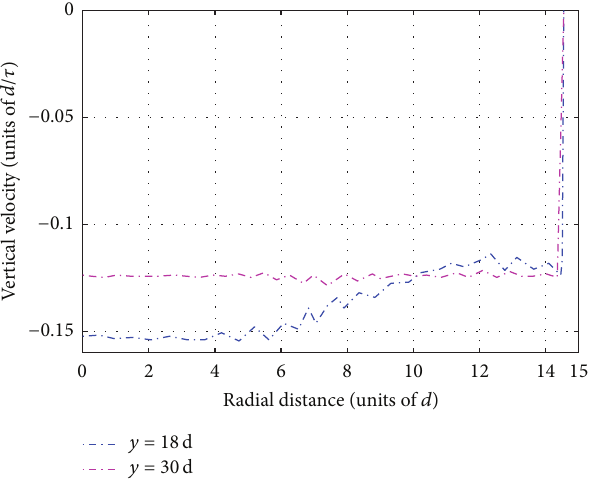
Figure 5: Comparison of velocity profiles for simulations without wall friction for two different heights by Rycroft et al.